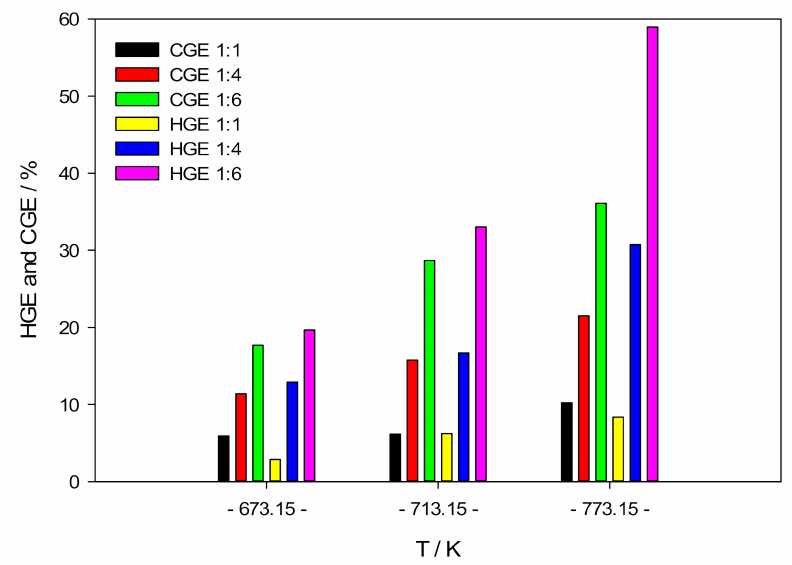
Figure 6. CGE and HGE of SCWG from guava fruit waste based on B:W mass